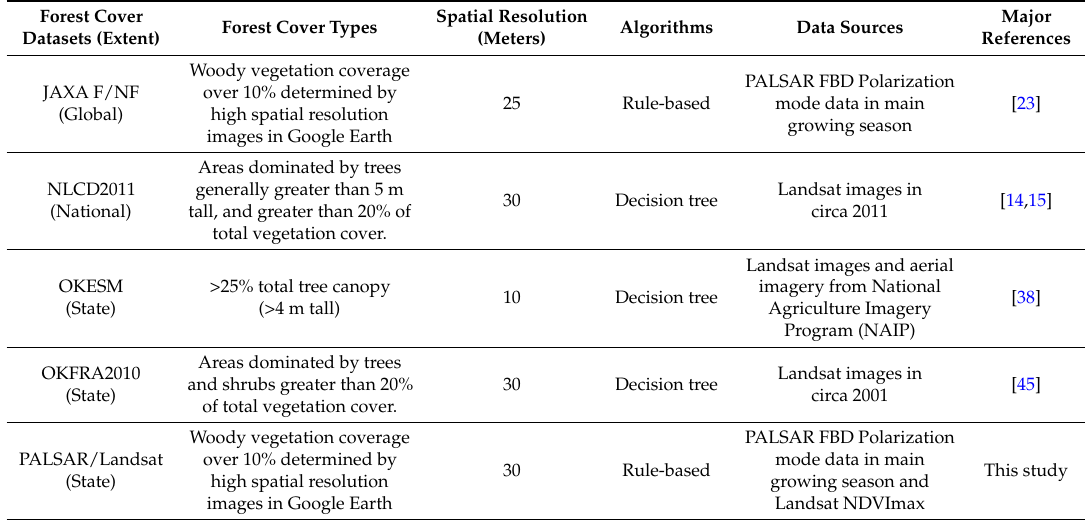
Table 1. Summary of the forest products for the area and spatial comparison in Oklahoma in circa